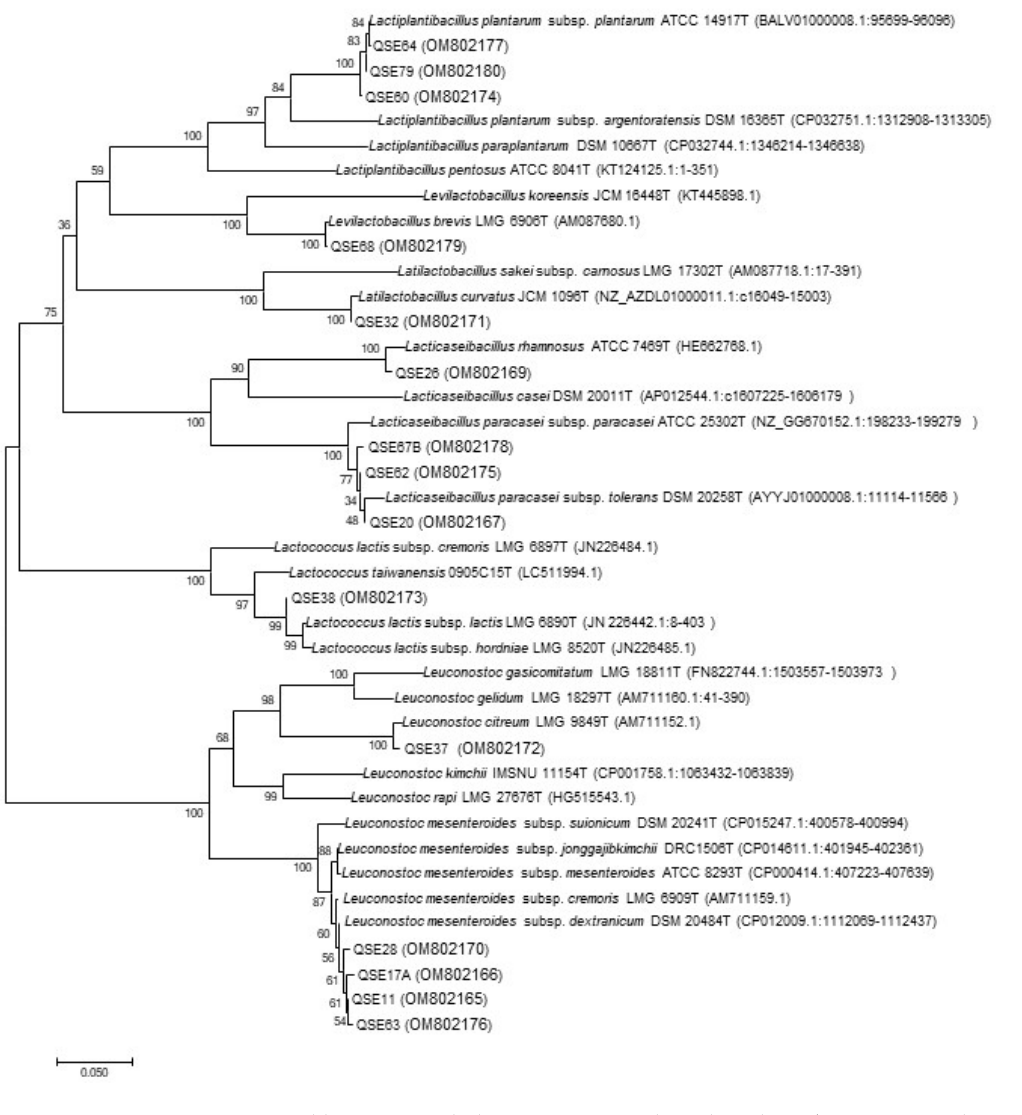
Figure 2. Neighbor-joining phylogenetic unrooted tree based on pheS gene partial sequences (400 nt) showing the taxonomic location of 15 representative strains from different groups of MALDI-TOF MS within the closely related type strains.